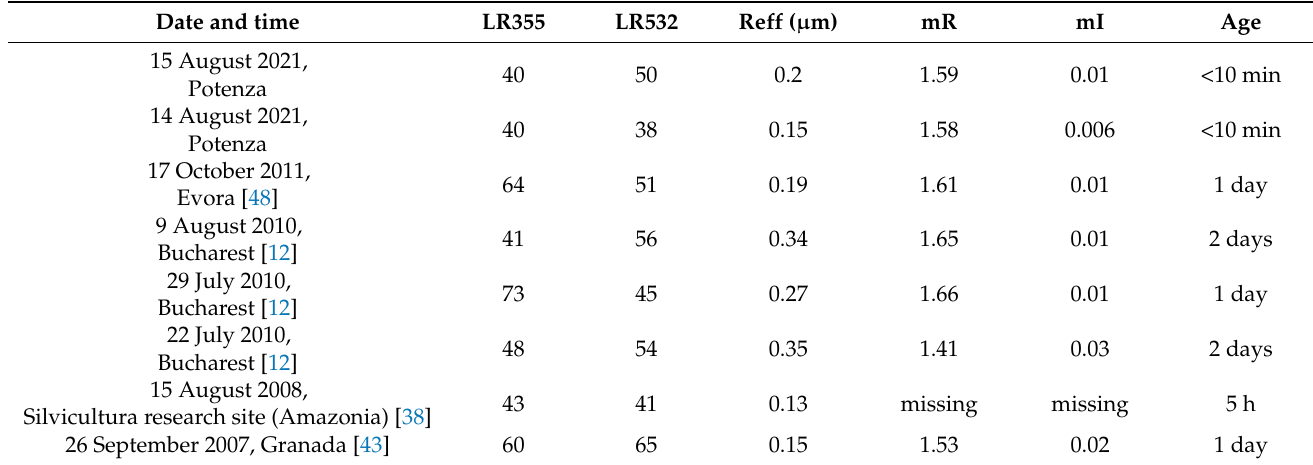
Table 1. Values of LR at 355 and 532 nm, effective radius (Reff), real part (mR), and imaginary part of refractive index (mI) from different measurements of fresh biomass burning [12,38,43,48]. The time of travel for the smoke layer is estimated assuming a mean wind speed (i.e., 7.8 m/s) for the smoke layer as provided by the ECMWF forecast for the CIAO location.